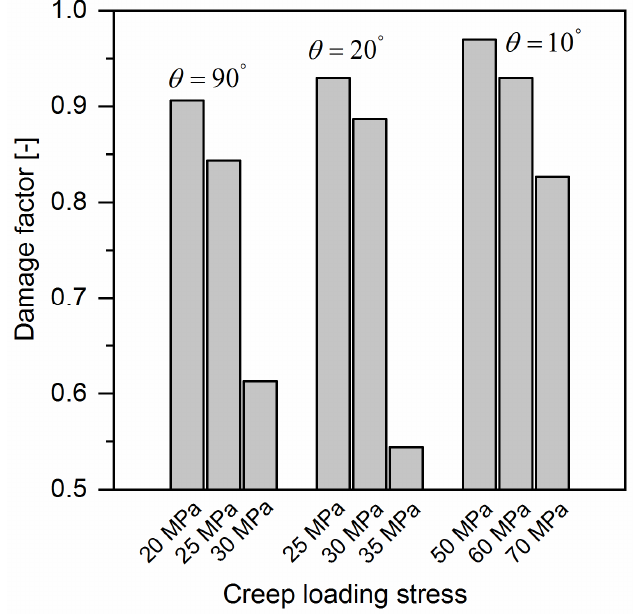
Figure 9. The comparison of elastic modulus of off ‐ axis samples after creep loading with initial elastic modulus.